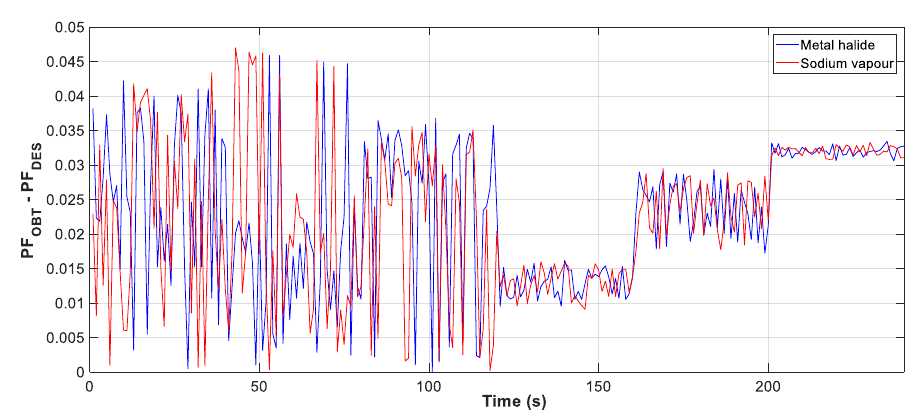
Figure 15. Di ff erence between PF OBT and PF DES (Metal Figure 15. Difference between PF OBT and PF DES (Metal halide).